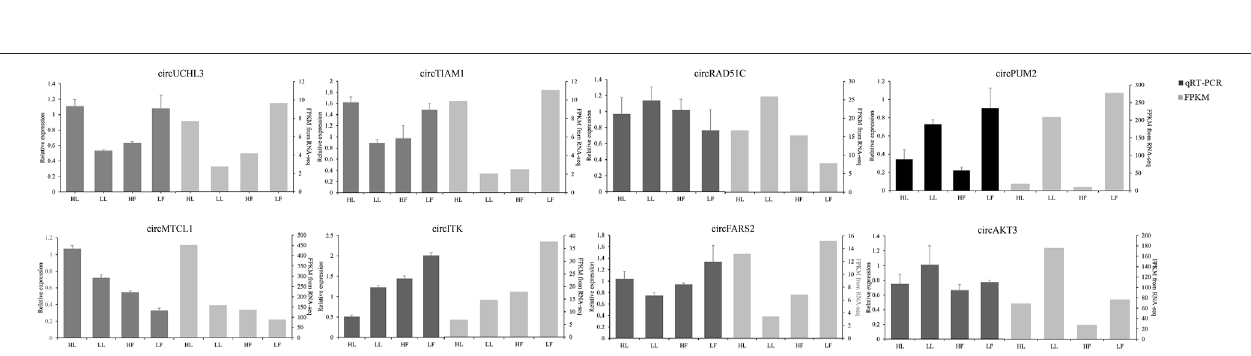
Frontiers in Physiology |